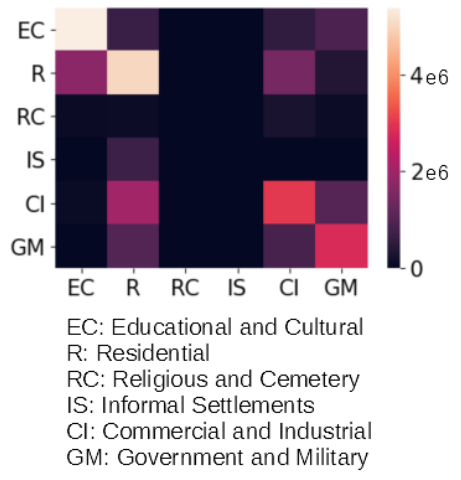
Figure 4. Confusion matrix of PMN on the three test tiles.